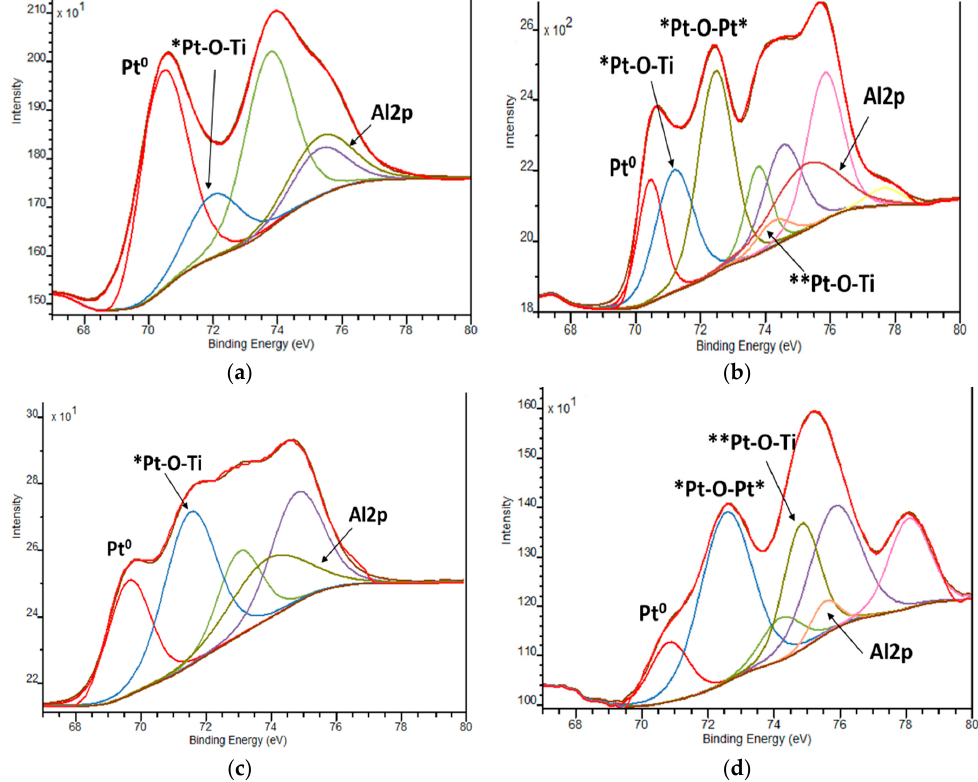
Figure 7. Deconvoluted Pt4f XPS spectra: ( a ) 1Pt,N-TiO 2M1 ; ( b )1Pt,N-TiO 2M2 ; ( c ) 1Pt,N-TiO 2M1UV ; ( d ) 1Pt,N-TiO 2M2UV . Pt 0 , *Pt and **Pt are related to Pt in 0, +2 and +4 oxidation states, respectively.